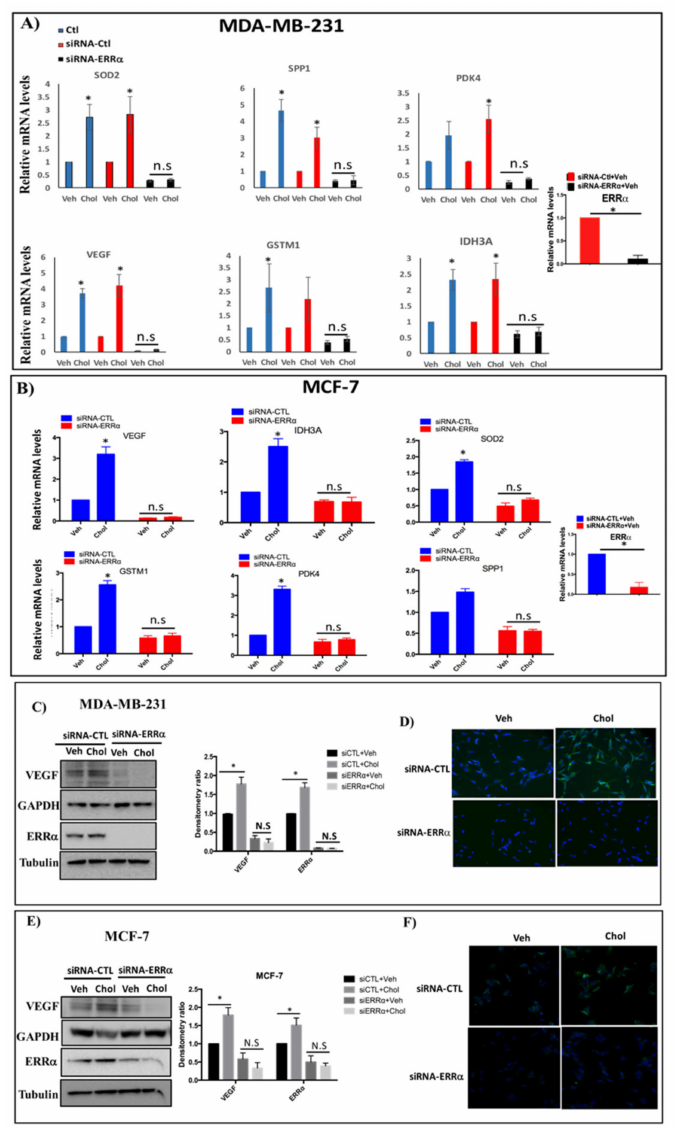
Figure 4. Cholesterol enhances expression of ERR α metabolic target genes through ERR α in MDA-MB-231 and MCF-7 cells. ( A , B ) Cells were transfected with siRNA-ERR α (siERR α ) or siRNA-control (siRNA-CTL) for 48 h, and treated with vehicle (Veh) or cholesterol (Chol, 5 µ M) for 24 h. Total RNA was extracted and analyzed by RT-qPCR. Genes detected included: isocitrate dehydrogenase 3A (IDH3A), pyruvate dehydrogenase kinase 4 (PDK4), vascular endothelial growth factor (VEGF), glutathione s-transfrase M1(GSTM1), superoxide dismutase 2 (SOD2) and secreted phosphoprotein 1(SPP1). The mRNA data were normalized to endogenous GAPDH ( C , E ) Cholesterol increases ERR α -induced VEGF protein expression in MDA-MB-231 and MCF-7 cells using western blotting. The blots for ERR α and VEGF were generated from the same cell lysates loaded on 2 different gels due to the similar molecular weights of the two proteins. GAPDH was used as a loading control for VEGF and tubulin was used as a loading control for ERR α . The densitometry ratio was calculated using ImageJ software. ( D , F ) Immunocytochemistry (ICC) was performed to detect VEGF protein expression using anti-VEGF antibody. All cells were transfected with siRNA-ERR α or siRNA-control (siRNA-CTL), and were treated with cholesterol (5 µ M for MDA-MB-231, 10 µ M for MCF-7 cells) or with vehicle for 24 h. DAPI is shown in blue and VEGF in green. A minimum of three independent experiments were performed. A value of p < 0.05 was considered significant in the comparison with the control group